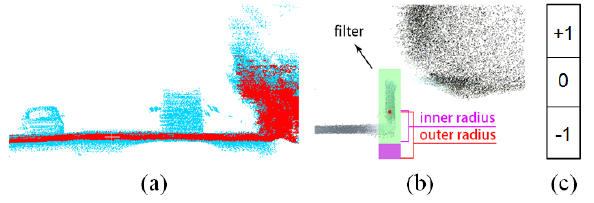
Figure 3. (a) Road objects elimination (cars in blue color, ground in red color). (b) Ground filter. Current point will be determined as a ground point if no point detected in purple region. (c) Differential filter. Table 1. Results of Ground Points Extraction on millimeter-level (CRR) and centimeter-level accuracy (KITTI) LiDAR data. is no other point between the inner radius and the outer radius (purple region), the current point will be treated as a ground point. According to the gap between the inner radius and the outer radius, most of the curb points are retained. Finally, the ground points are clustered by Euclidean distance. The processed results of three steps on millimeter-level (CRR) and centimeter-level accuracy (KITTI) LiDAR data are shown in Table 1.